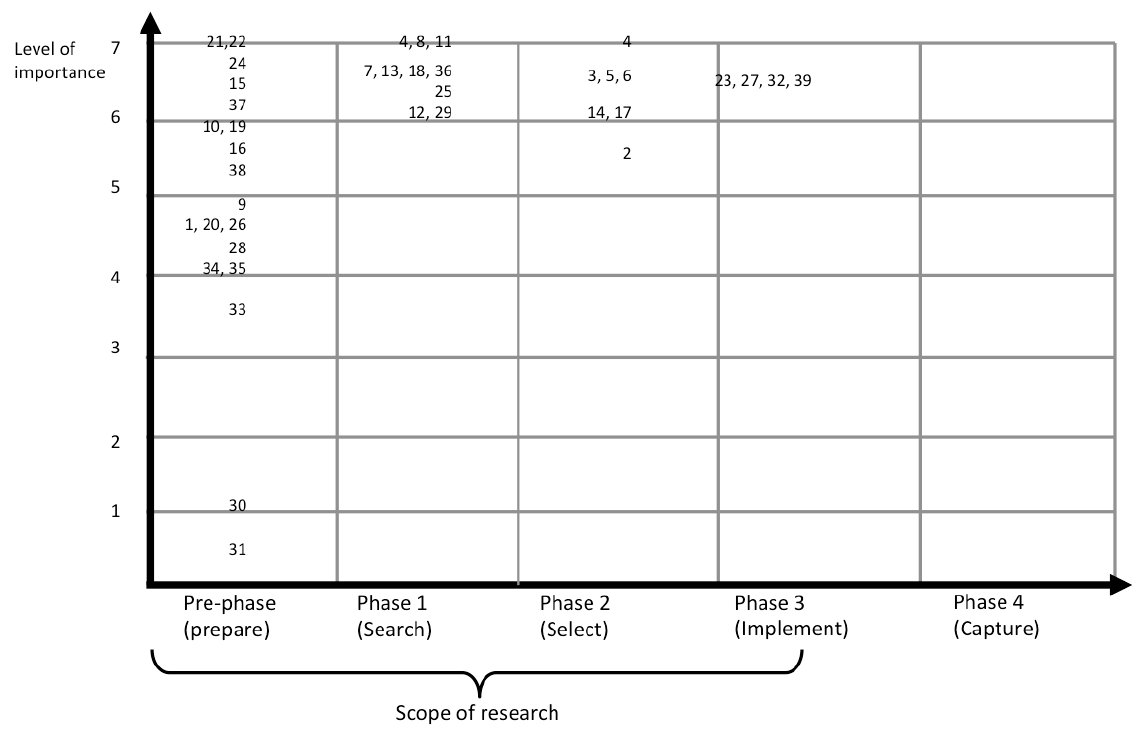
Fig. 4. The figure demonstrates when the facilitator’s characteristics are most important in innovation projects, according to the